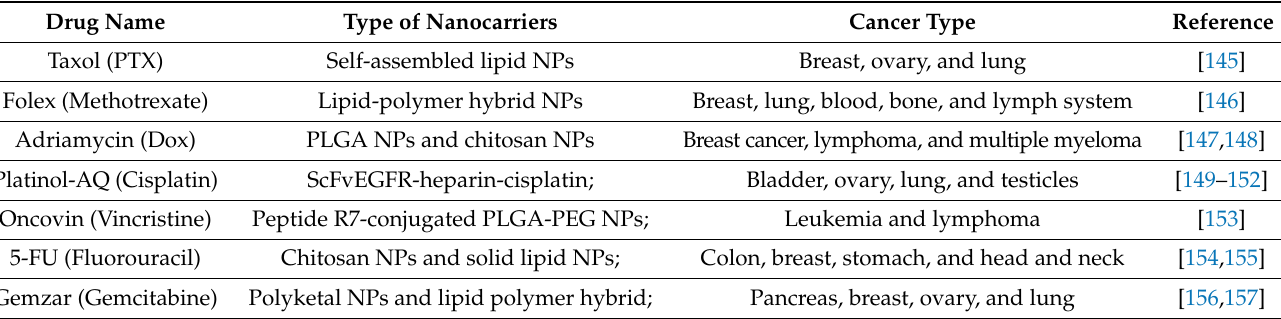
Table 1. List of polymer NPs for Cancer